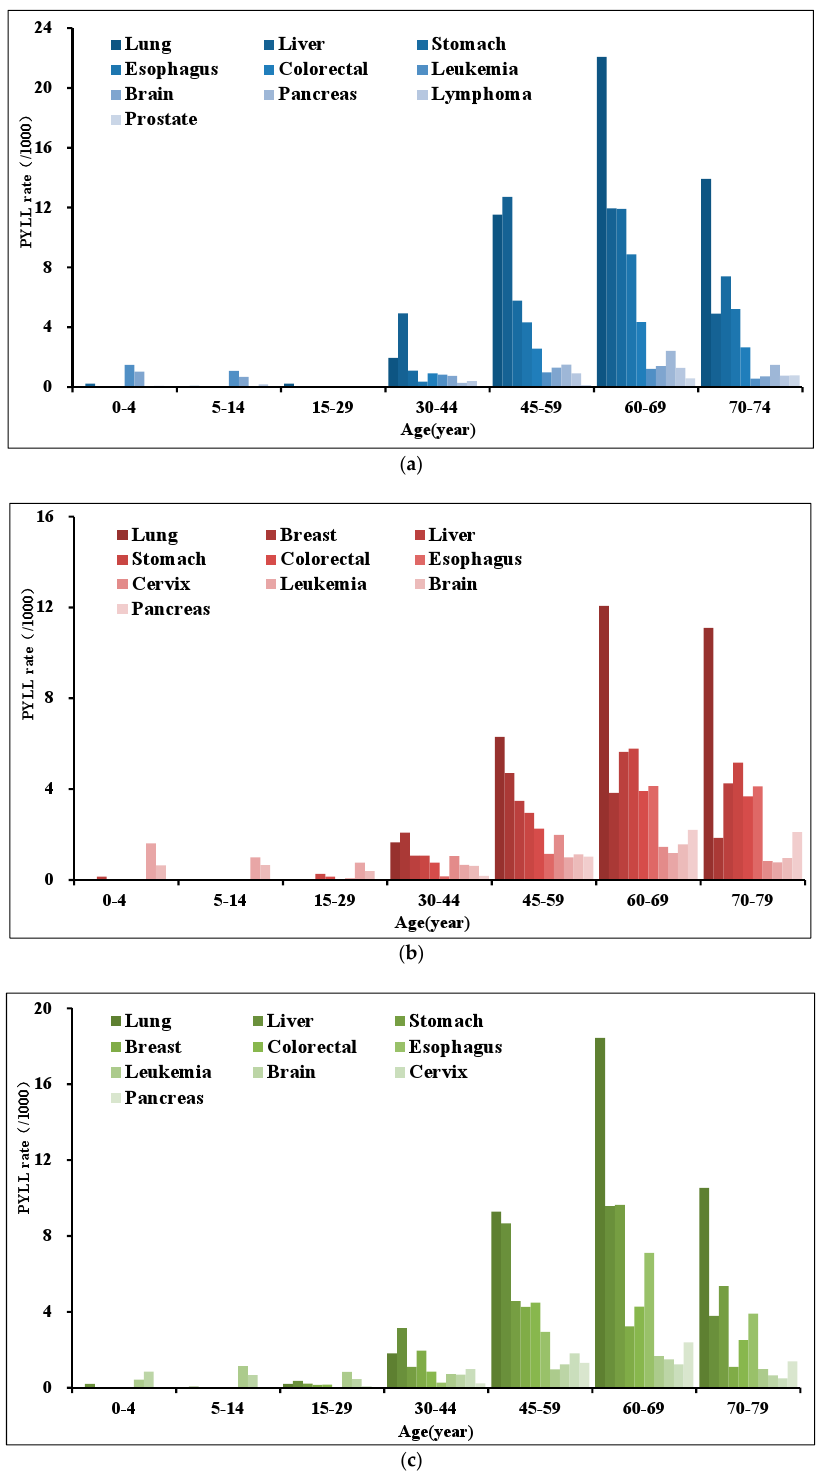
Figure 2. PYLL age distribution of high-death-risk cancers in China, 2013. ( a ) males; ( b ) females; ( c ) both.